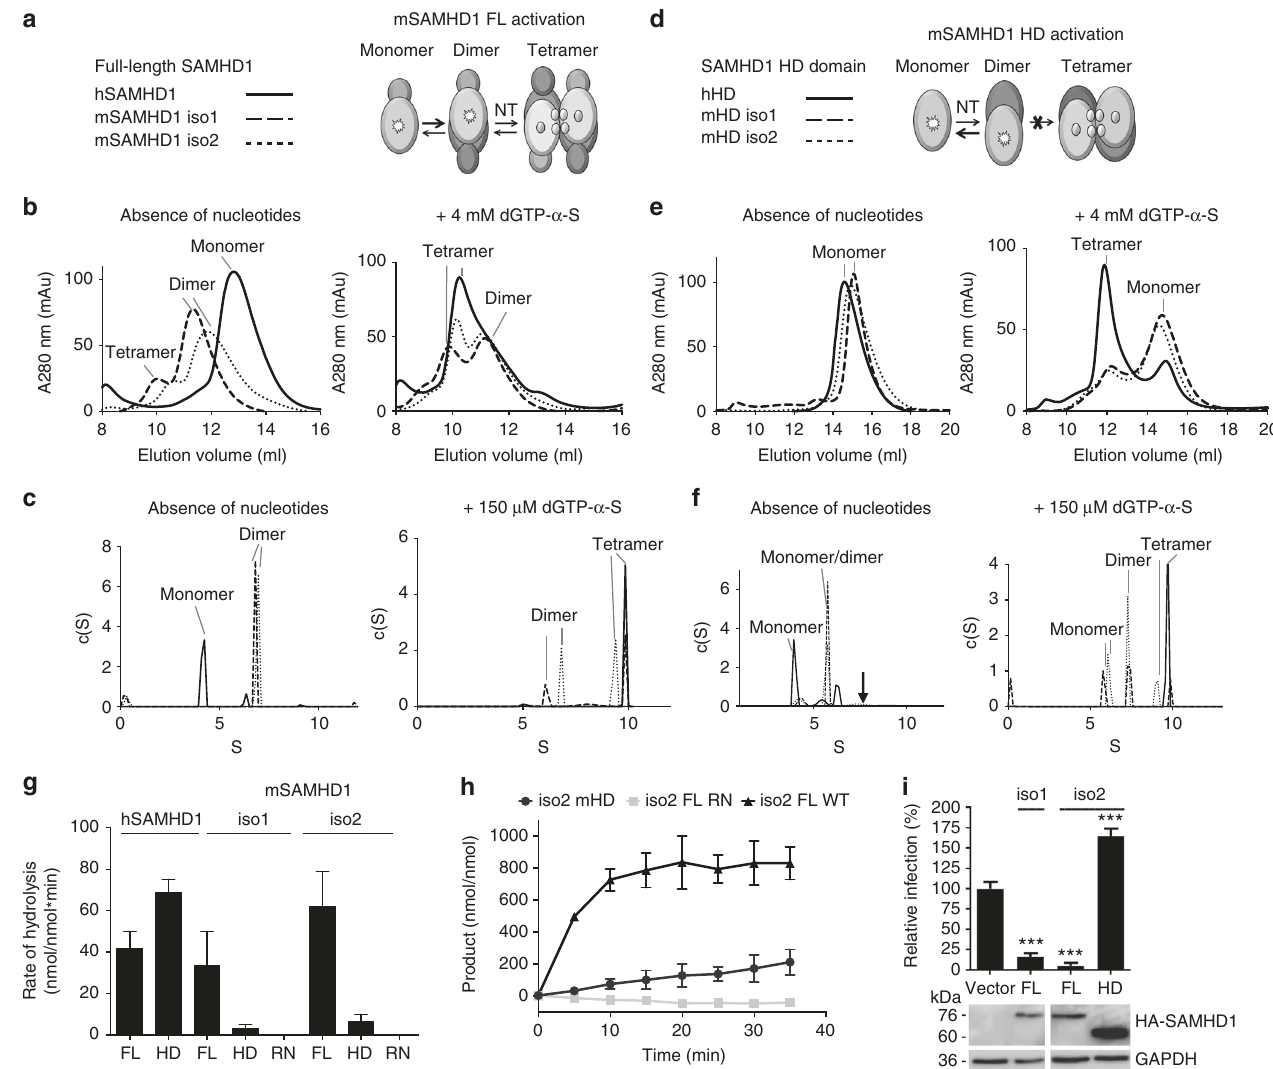
Fig. 1 SAM domain of mSAMHD1 is required for tetramerization and function. a , d Cartoon schematics depicting oligomer states induced by adding nucleotides to full-length (FL) mSAMHD1 or its HD domain protein construct. b , e SEC analysis of puri fi ed SAMHD1 samples with (right) or without (left) nucleotides added. c , f AUC analysis of puri fi ed SAMHD1 samples with (right) or without (left) nucleotides added. The arrow in the left panel of ( f ) marks the position of HD dimer formed in presence of added nucleotides (right panel). g dNTPase assay for full-length, HD, and RN (inactive mutant) constructs of hSAMHD1 and mSAMHD1. Reaction products were quanti fi ed by HPLC. Each experiment was performed in triplicate. Error bars represent stand error (s.d.). h dNTPase activity assay for full-length, HD, and RN constructs of mSAMHD1. Reaction products were quanti fi ed by the malachite green assay. Each experiment was performed in triplicate. Error bars, s.d. ( i ) HIV-1 restriction by full-length mSAMHD1 iso1 and iso2, but not the HD domain of mSAMHD1 iso2. SAMHD1 proteins were stably expressed in U937 cells after PMA differentiation. HA-tagged SAMHD1 expression was con fi rmed by immunoblotting (uncropped images in Supplementary Fig. 7). GAPDH was used as a loading control. Single-cycle HIV-1 infection of vector control cells was set as 100%. Each experiment was performed in triplicate. Error bars represent standard deviation (s.d.) *** p ≤